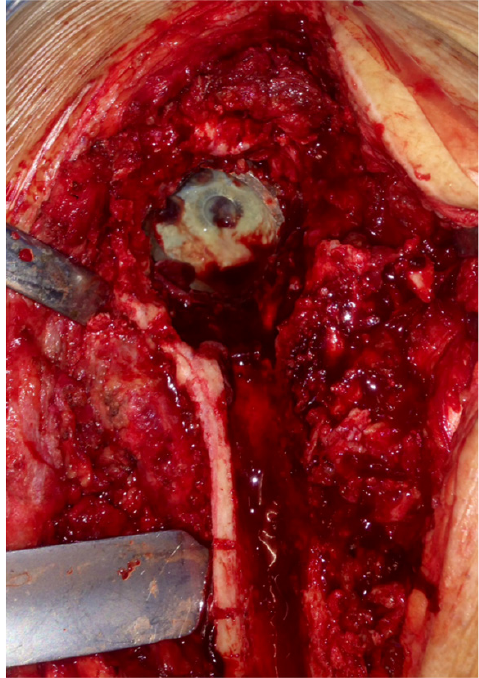
Figure 2: Intraoperative photograph shows the infected acetabular cup. The femoral stem has been removed via Paprosky